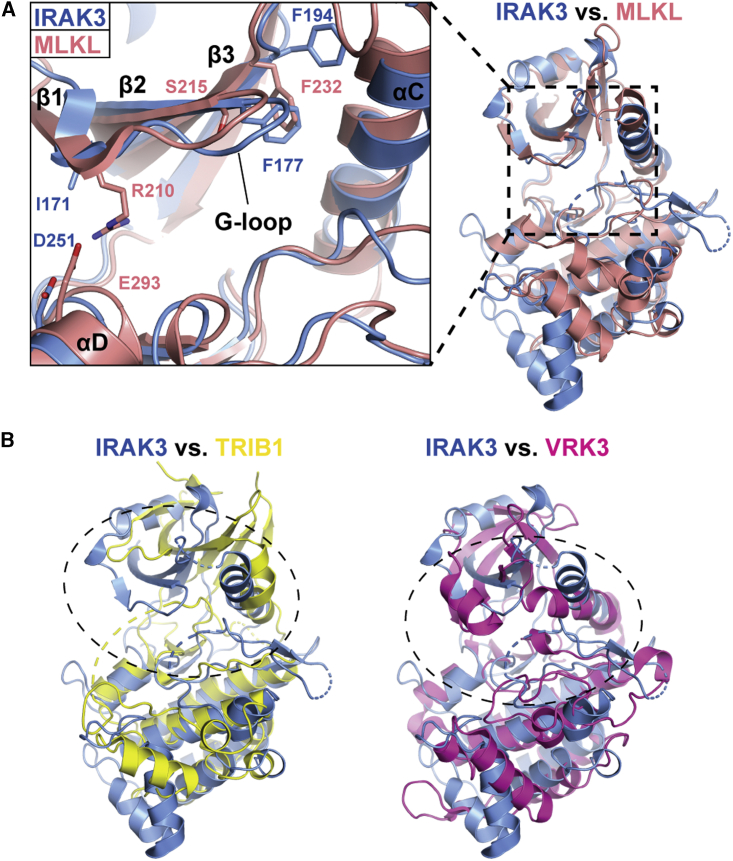
Active Site Comparison between IRAK3 and Other Pseudokinases(A) Superposition of IRAK3 (blue) with the pseudokinase MLKL (salmon, PDB 4WMI; Murphy et al., 2014) and close-up view of the G-loop stabilizing residues shown as stick models.(B) Superposition of IRAK3 (blue) with the pseudokinases TRIB1 (yellow, PDB 5CEM; Murphy et al., 2015) and VRK3 (magenta, PDB 2JII; Scheeff et al., 2009). Dotted circles indicate the severely altered ATP-binding pockets of TRIB1 and VRK3.